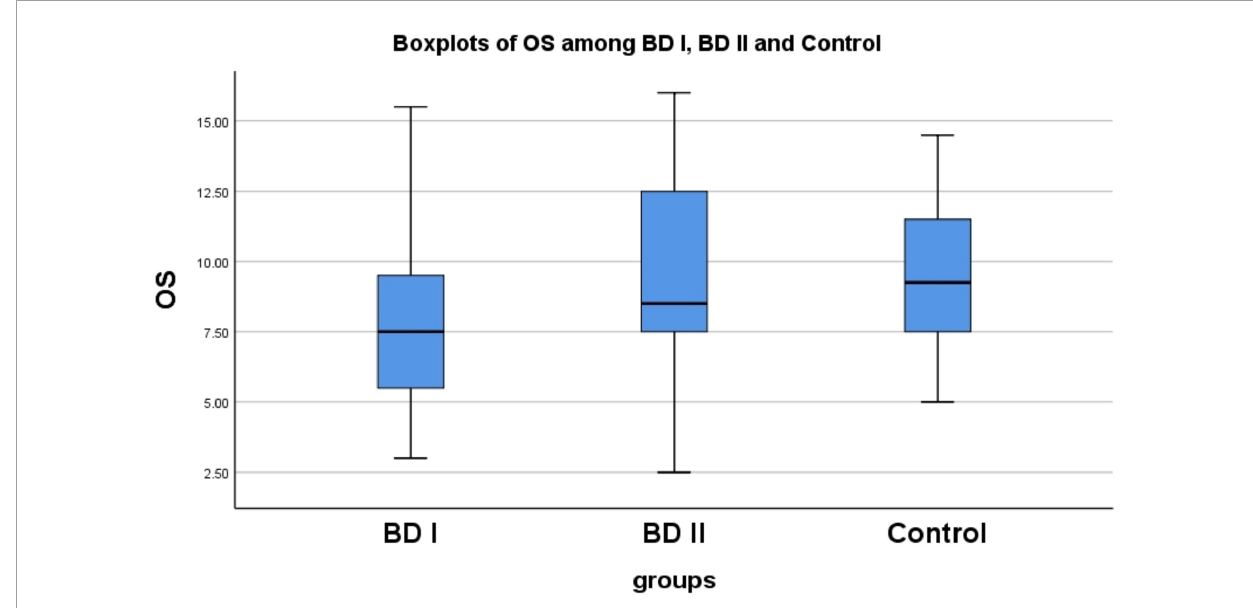
FIGURE1 There are statistically significant differences in OS between BD I group and control ( p < 0.001), similarly between BD I group and BD II group ( P = 0.008). OS, olfactory sensitivity; BD, bipolar disorder; BD I, bipolar I disorder; BD II, bipolar II